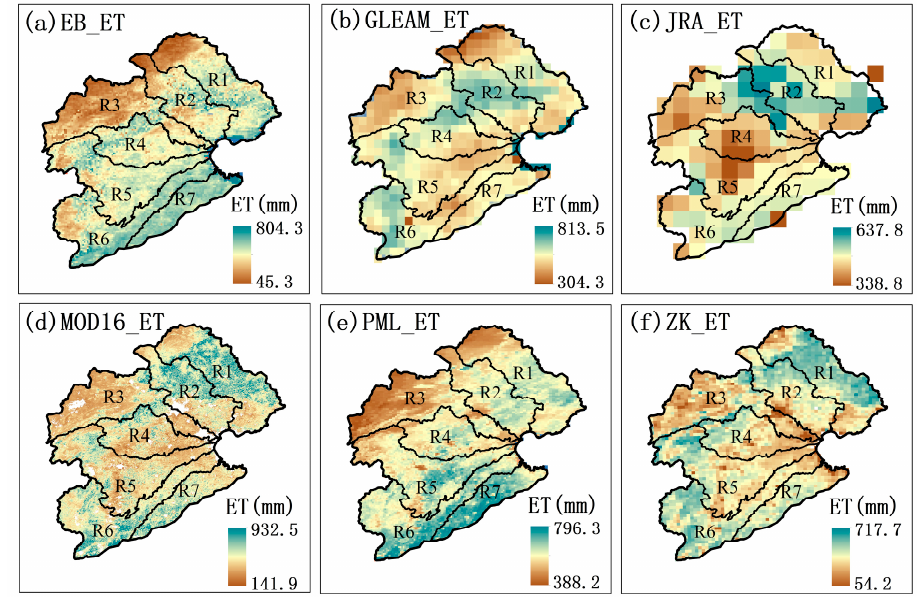
Figure 12. Spatial distribution of mean annual ET from 2003 to 2012.